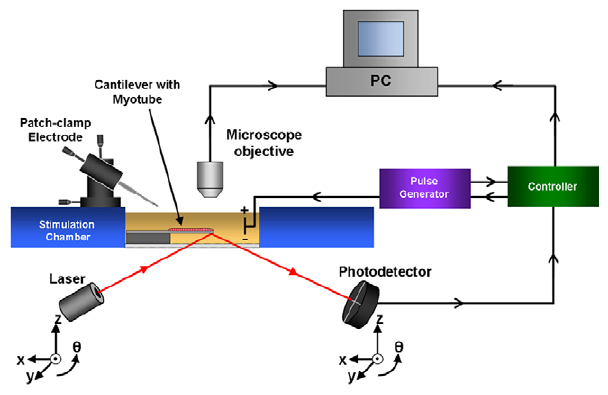
Figure 1. Schematic representation of cantilever deflection system for recording myotube contractions.